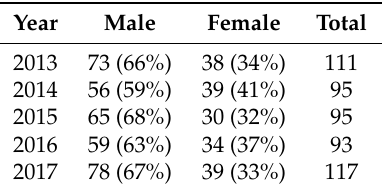
Table 1. Number of male and female suicides among Dutch youths under 23 years old in the years 2013 to 2017 (percentage of total in year in brackets).